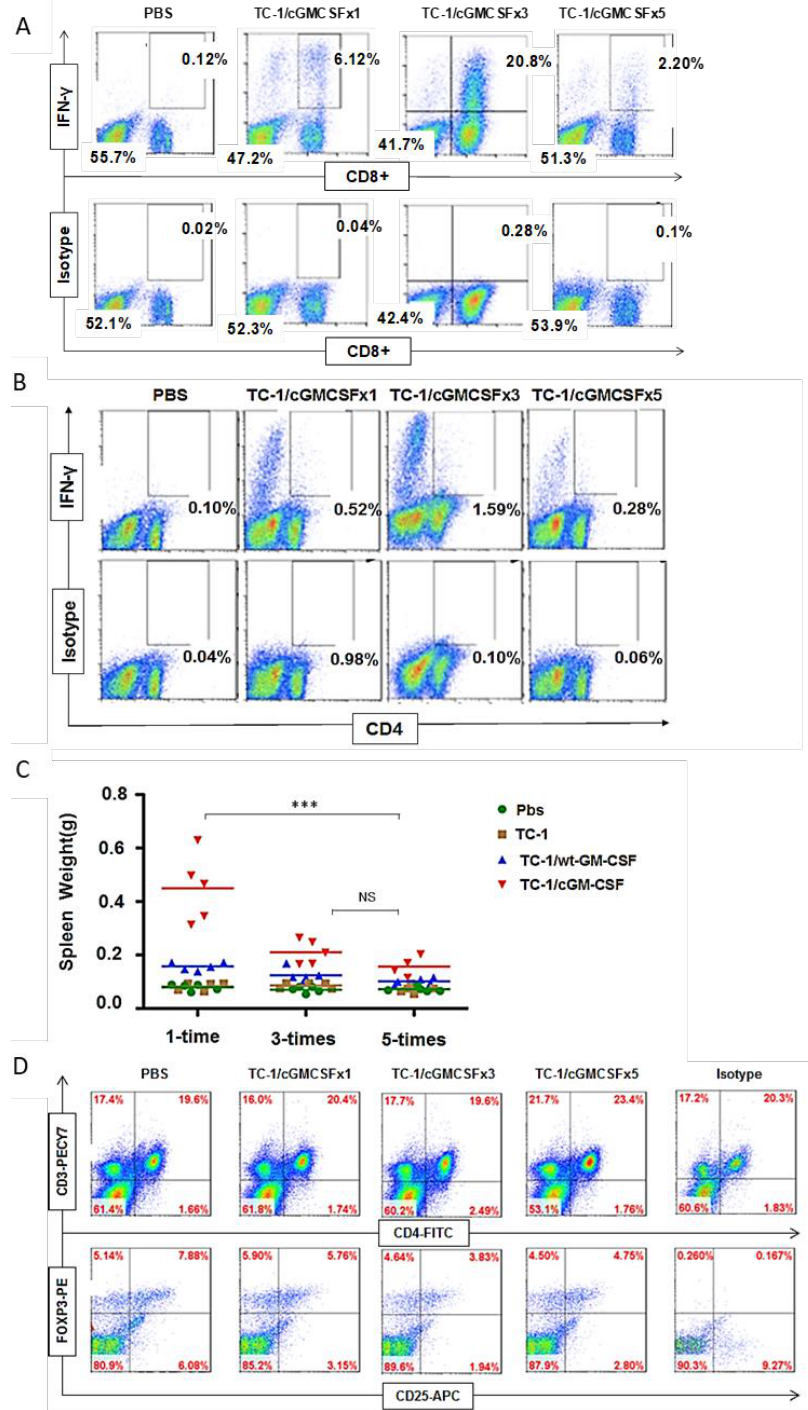
Figure 3. Vaccinating three times with cGM-CSF generates a higher IFN- γ -secreting CD8 + T and CD4 + T cell response compared with five-time vaccination. C57BL/6 mice were subcutaneously immunized with irradiated TC-1/cGM-CSF in the dorsal flank. Seven days after the last immunization, cells were isolated from spleens and re-stimulated with 10 µ g/mL human papillomavirus (HPV)-16 E7 MHC class II peptide. IFN- γ -secreting cells ( A ) CD8 + T and ( B ) CD4 + T cells after one time, three times, and five times vaccinations were analyzed. ( C ) Spleen weight was analyzed after vaccination one time, three times, and five times. ( D ) FoxP3-positive (Regulatory T cell (T reg )) subsets were analyzed after vaccination one time, three times, and five times with irradiated TC-1/cGM-CSF. The data are presented as the mean SD of triplicate values. *** p < 0.001; single-classification